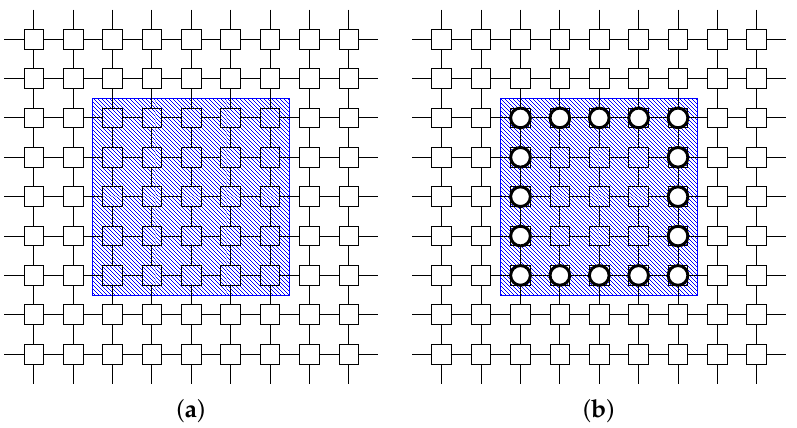
Figure 5. Application example of protecting tactic for Safe Zone. ( a ) Before. The blue area represents a Safe Zone. ( b ) After. The white-hat worms are placed to frame the zone.